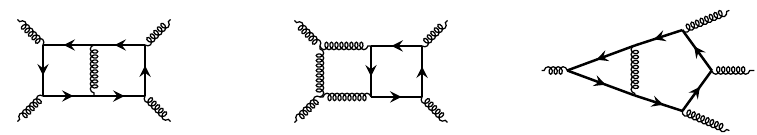
Figure 2. Three two-loop masters with four external vector